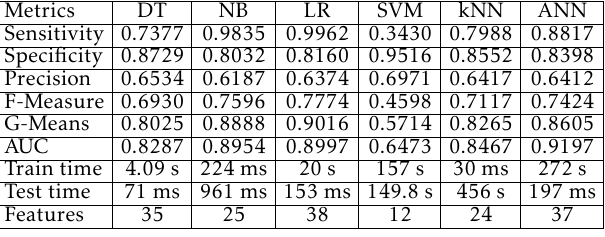
Table 32. Results of using GR-BFE algorithm on EXPLOITS.